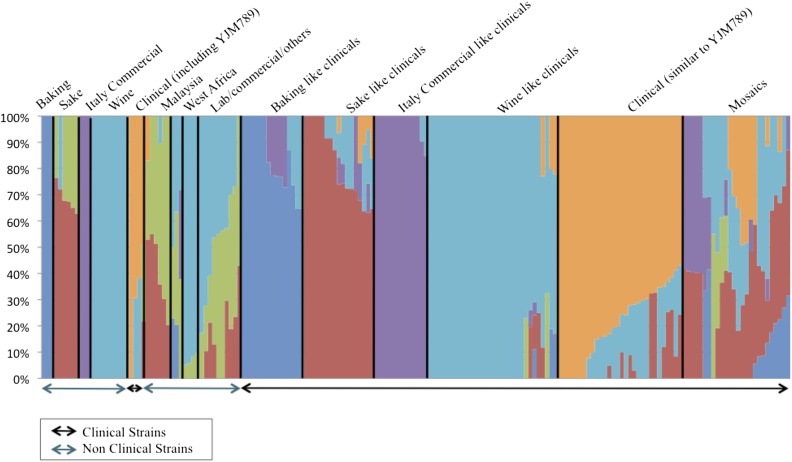
Structure assignment of source populations for all 180 strains. Strains are aligned from left to right (x-axis) and sorted by their percentage composition of each population (y-axis) as computed by Structure. Source populations are annotated with text above the figure. Clinical or nonclinical strains are annotated with arrows below the figure. Structure (version 2.3.2) analysis was run with correlated frequencies, admixture model based on base pair distance from preceding SNP, 15,000 burn in period, and 5000 iterations of sampling.